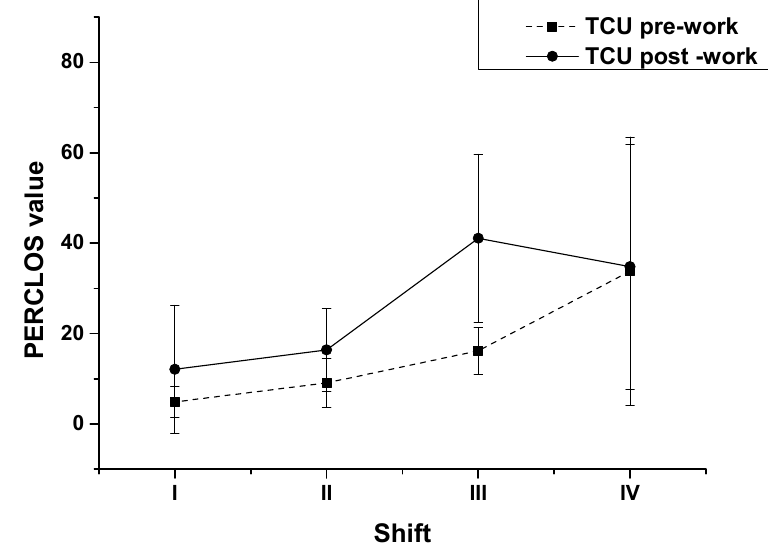
Figure 7. PERCLOS values of ATCOs at the TCU by shift. Table 8. Comparisons of the influence of circadian rhythm on ATCOs’ PERCLOS values by work type.